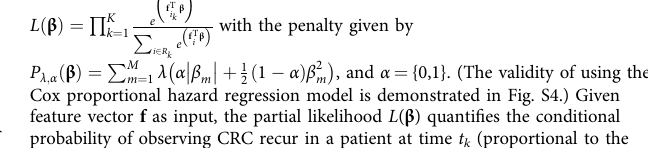
Supplementary Table 5. Broadly, the supporting information details the hyper- plexed immuno fl uorescence work fl ow with information on iterative cycles of antibody labeling of single 5 µm formalin- fi xed and paraf fi n-embedded tissue sections and TMA slides, auto fl uorescence removal, imaging, and dye inactivation in tissue. All samples were stained and imaged in a single batch for 2 – 3 biomarkers and DAPI at a time. Image processing and single-cell analysis . DAPI-based nuclear staining was used to register and align sequentially labeled and imaged TMA spots prior to downstream image analysis steps 19 . Auto fl uorescence was removed from the stained images 19,66 , which were then segmented into epithelial and stromal regions (Supplementary Fig. 3), differentiated by epithelial E-cadherin staining. This was followed by segmentation of individual cells in both the epithelium and stroma. Epithelial cells were segmented using Na + K + ATPase-based cell-membrane stain- ing to delineate cell borders and membrane regions, the cytoplasmic